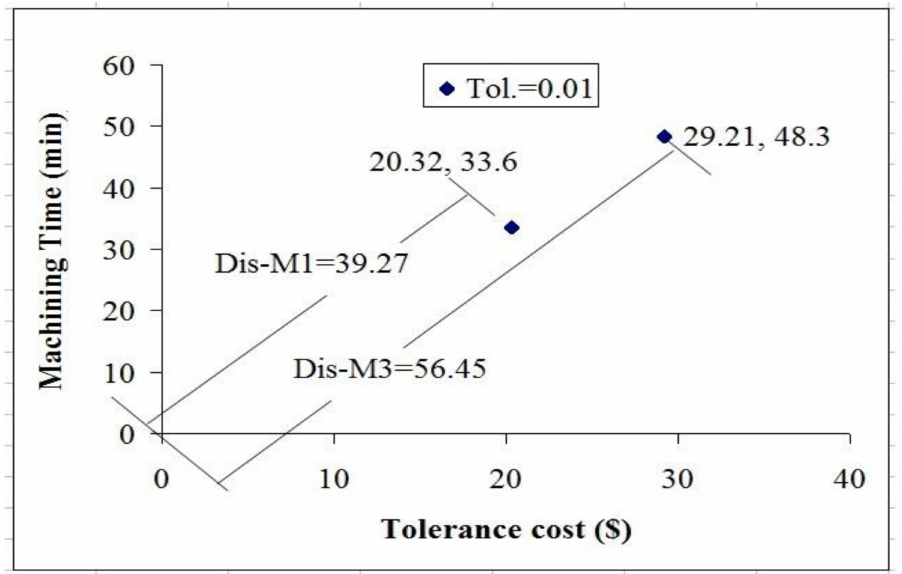
Figure 4. Selection of the best machine based on discrete tolerance. TC e 11 —tolerance cost of e th discrete tolerance using process number 1 on machine number 1; MT e 13 —machining time of e th discrete tolerance using process number 1 on machine number